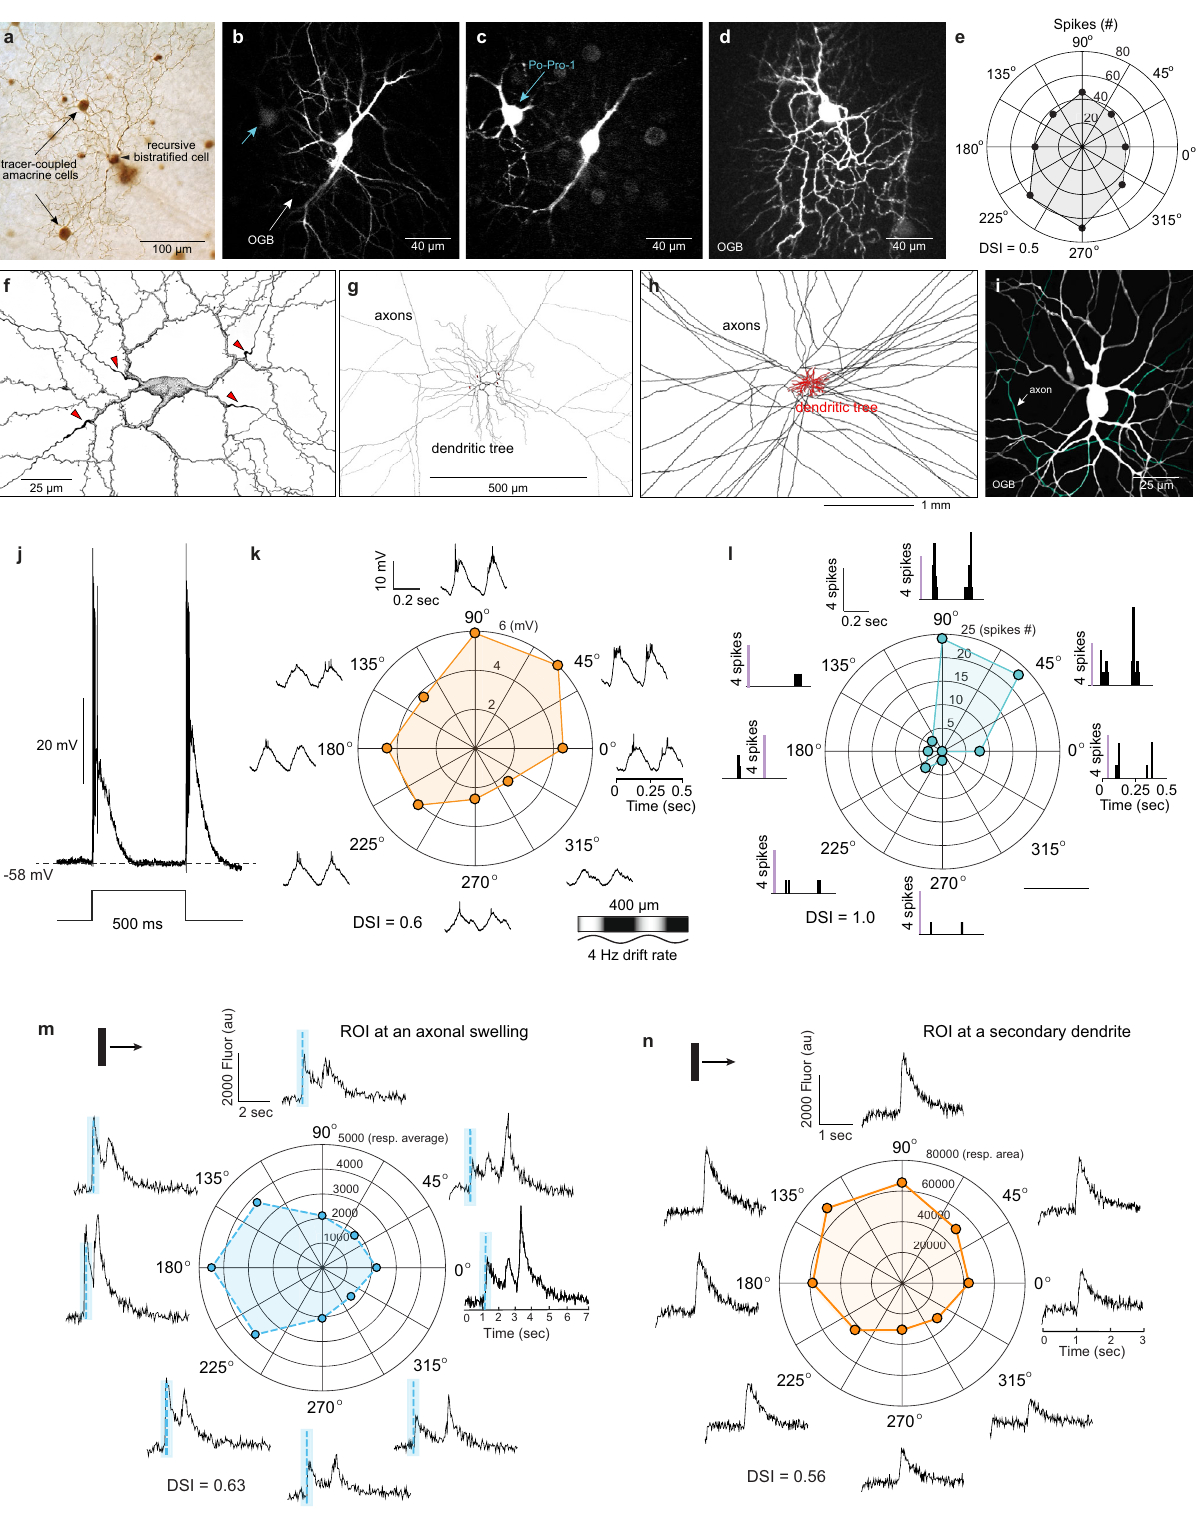
Given the link to the recursive bistrati fi ed cell and its similar (OGB) during intracellular recording (Fig. 4i) and both the long- transient, ON – OFF spiking response (Fig. 4j), we tested the A1 projecting axons and the thick, spiny dendrites showed stimulus- cell for direction selectivity. The membrane voltage recorded at evoked direction-selective Ca 2 + signals (Fig. 4m, n, respectively). the cell body showed directional tuning both for the modulation of the membrane potential (Fig. 4k) and the associated spike Connectomic reconstruction of A1 cells reveals polarization of discharge (Fig. 4l) in response to moving bar stimuli. A1 cells synaptic inputs and outputs . The A1 cell ’ s distinctive axon-like were fi lled with the calcium indicator Oregon Green BAPTA-488 NATURE COMMUNICATIONS| (2022) 13:2862